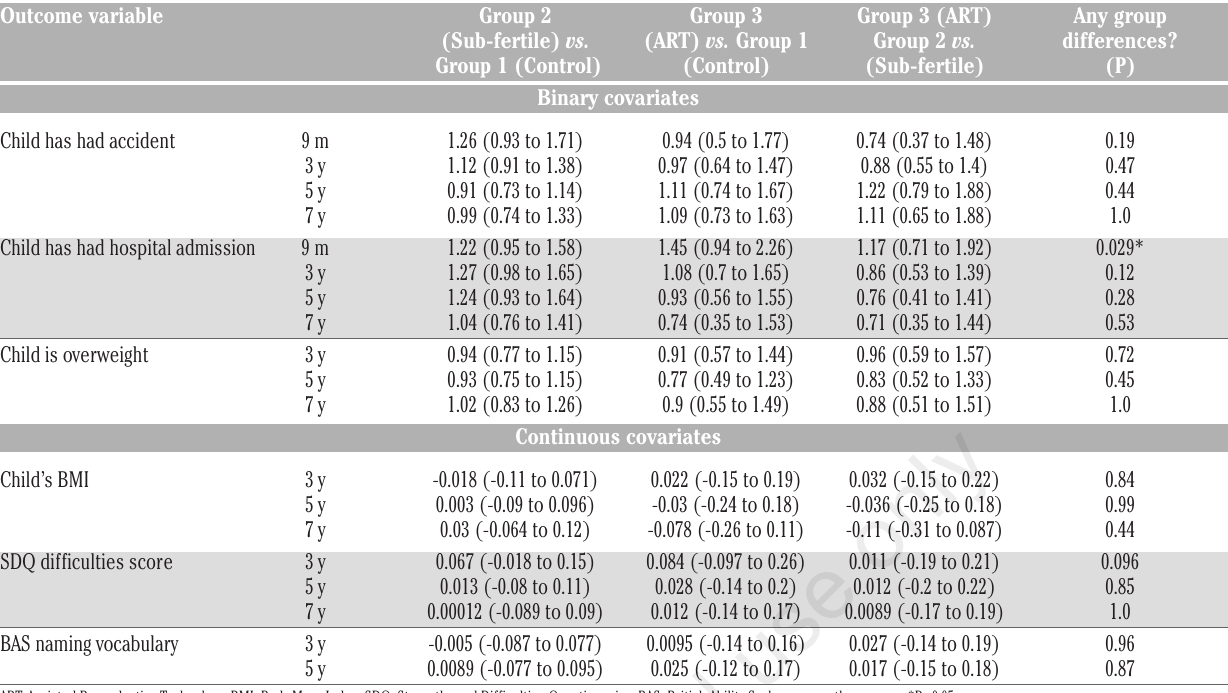
Table 5. Results of adjusted models. Group differences are given as odds ratios (binary variables) and differences in units of the stan- dard deviation (continuous variables) with 95% confidence intervals in brackets. The p-value for a test for any group differences is given. Higher SDQ Difficulties Score values indicate greater child difficulties. Higher BAS Naming Vocabulary Scores indicate larger child